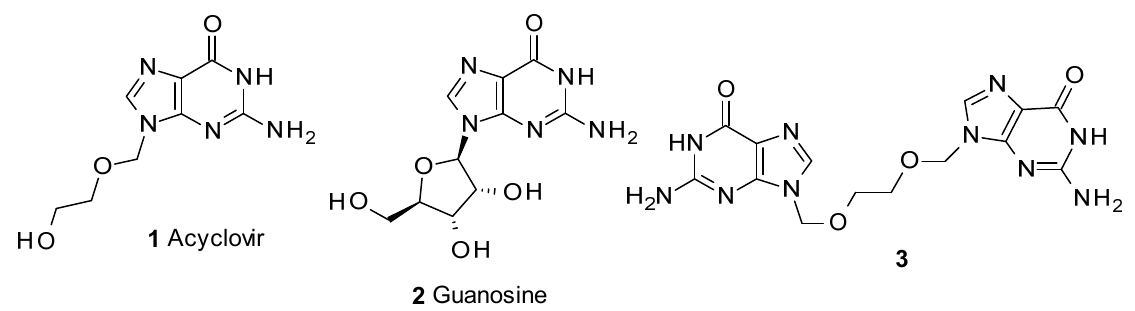
Figure 1. Acyclovir and related compounds.